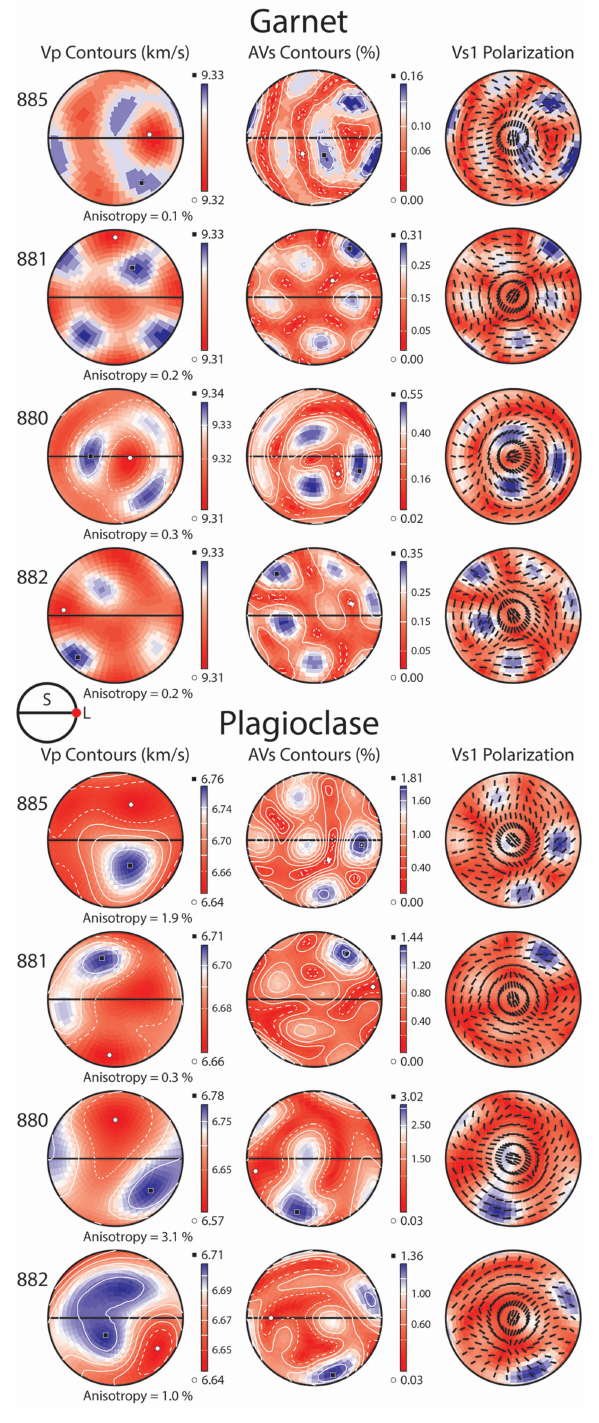
Figure 9. Seismic velocity and anisotropy of garnet and plagioclase. P-wave velocity (V P ) and seismic anisotropy of S-wave (AV S ) are shown. V S 1 polarization indicates the polarization direction of the fast shear wave (V S 1). S and L represent foliation and lineation,